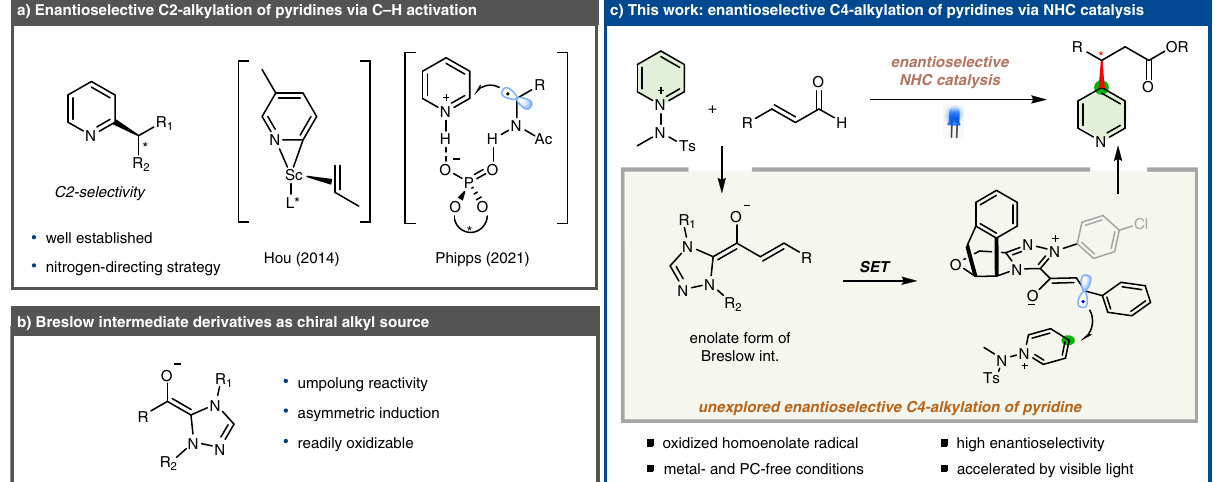
Fig. 1 Design plan. a Enantioselective C2-alkylation of pyridines. b Breslow intermediate derivatives as chiral alkyl source. c Enantioselective NHC- catalyzed β -pyridylation of enals with pyridyl